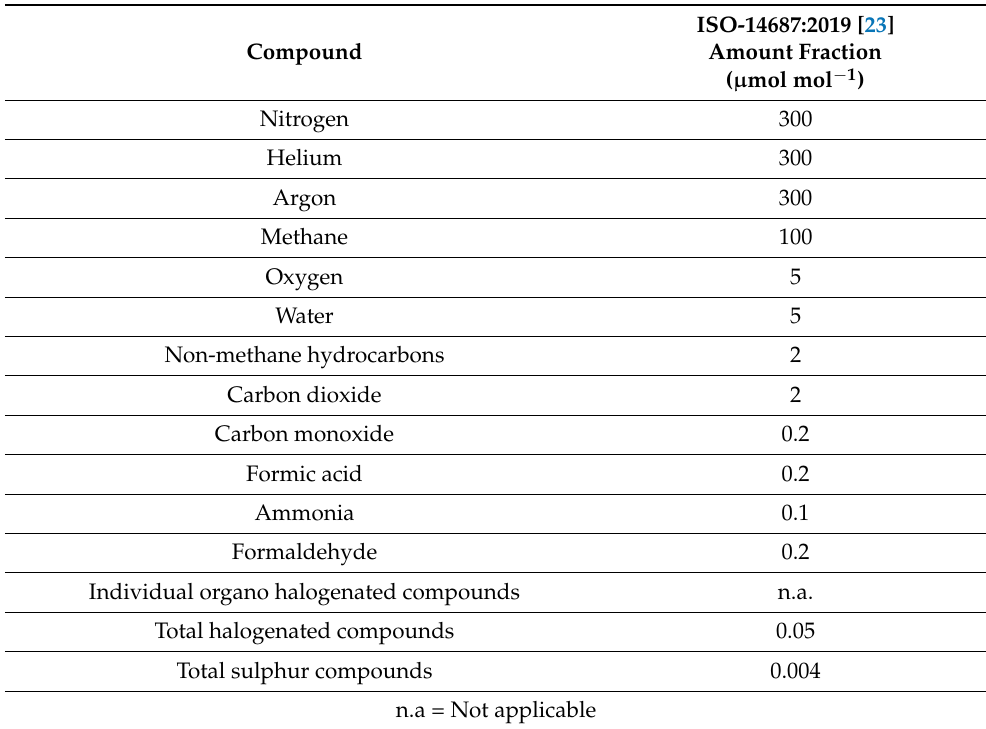
Table 1. Hydrogen fuel quality ISO14687:2019 for a proton exchange membrane (PEM) fuel cell road